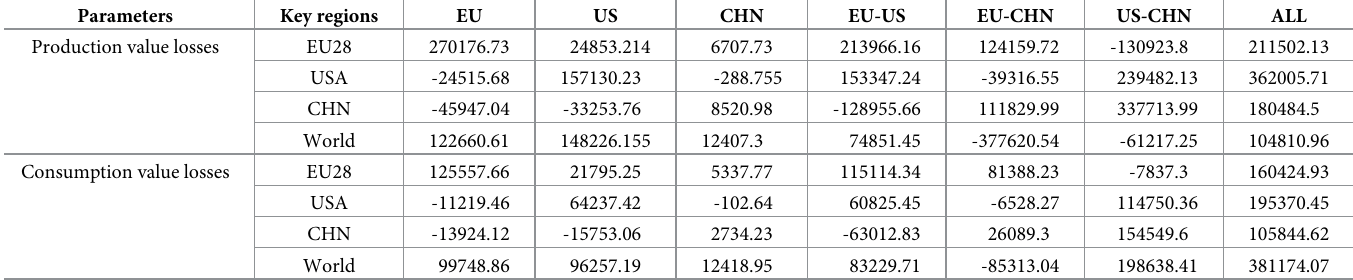
Table 3. Average production value and consumption value losses in all economic sectors for all forcing scenarios. A comparative analysis is done over the key agricul- tural regions. Values are in Billion USD. Parameters Key